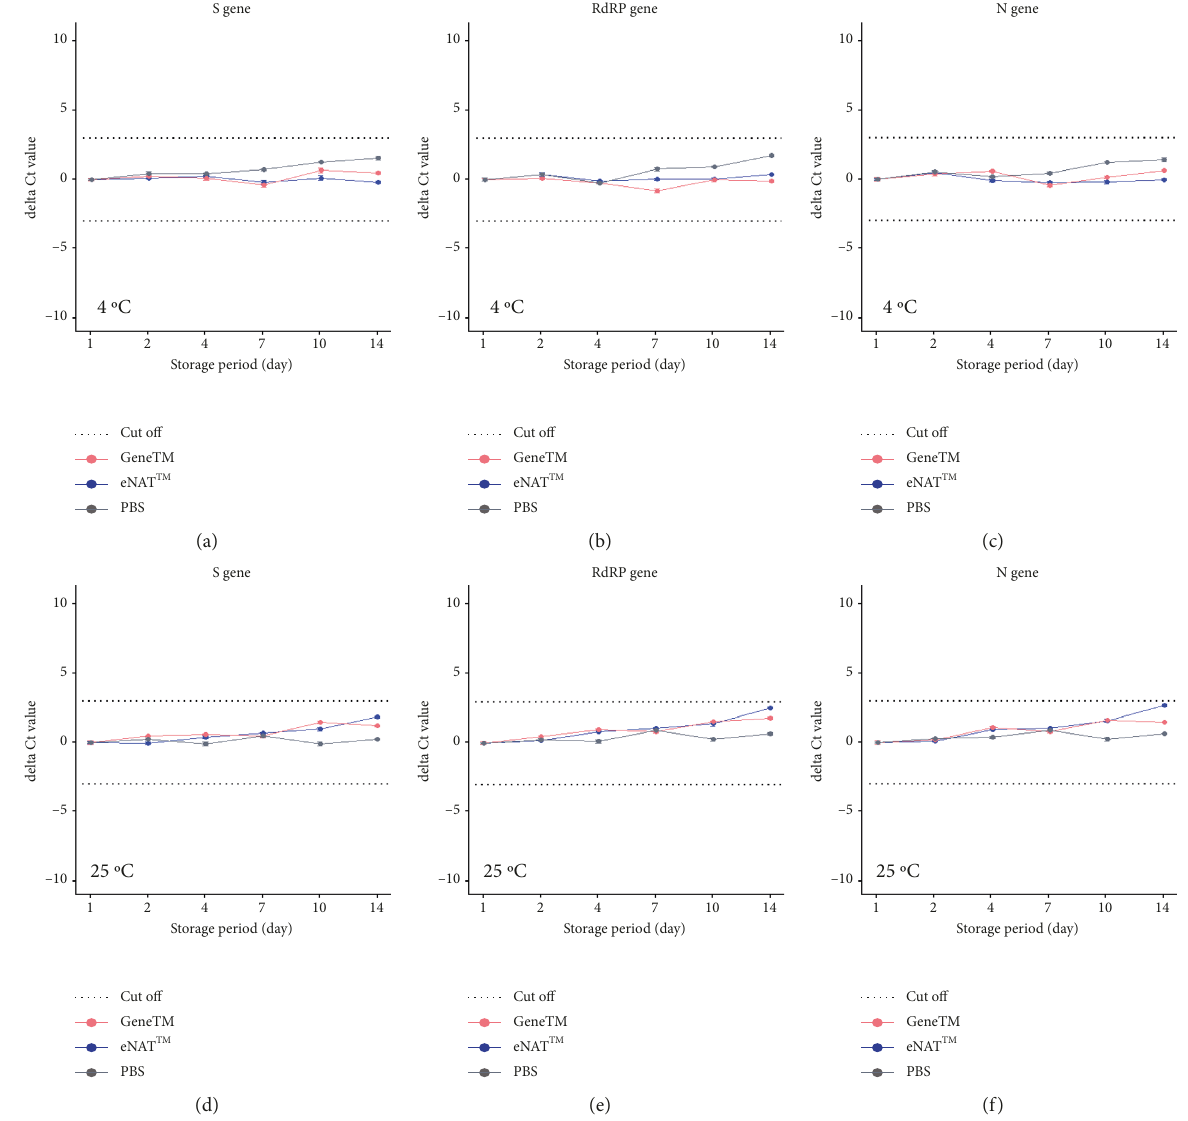
Figure 4: Stability of the SARS-CoV-2 (a, d) S gene, (b, e) RdRP gene, and (c, f) N gene following dilution of the NPS samples in CTM in GeneTM, eNAT ™ , or PBS at (a–c) cold temperature (4 ° C) and (d–f) room temperature (25 ° C). Six replicates per sample were assayed by real-time PCR under each of the indicated conditions. The dotted line indicated the cut-off value of ± 3 Ct, below which samples were deemed stable. Ct, cycle threshold; S gene, spike gene; RdRP gene, RNA-dependent RNA polymerase gene; N gene, nucleocapsid